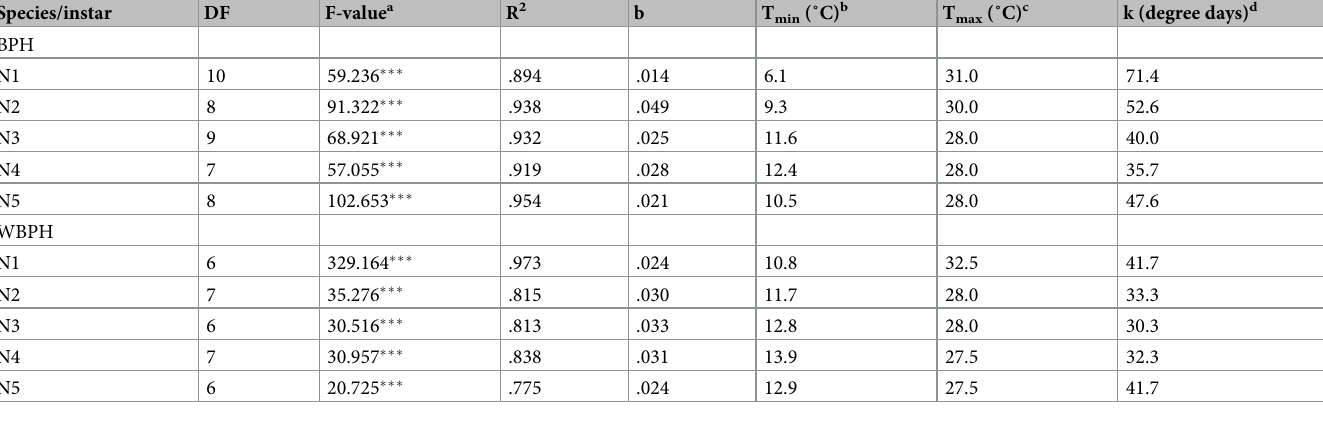
Table 5. Threshold estimates based on Campbell model for nymph development using available data (see also Fig 8).